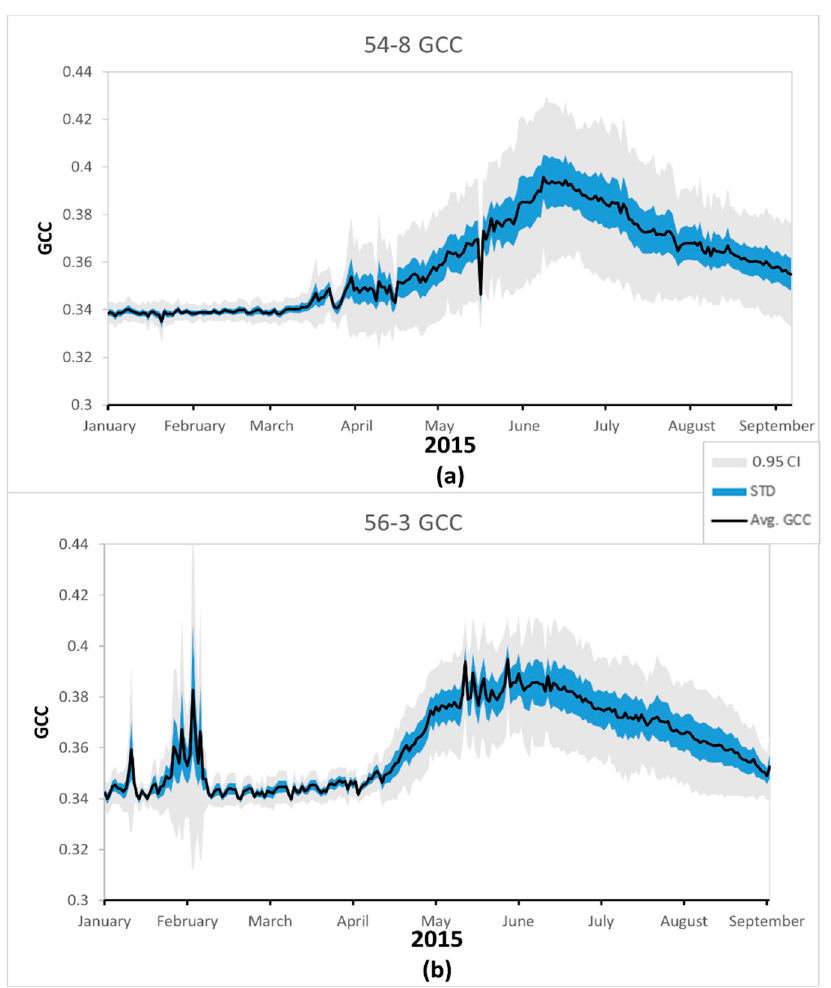
Figure 4. Daily GCC values from two rangeland sites 54-8 ( a ) with 4 cameras and 56-3 ( b ) with 5 cameras in the Idaho study area. Average GCC values for all cameras at a site is represented by the solid black line, one standard deviation (STD) is represented by the blue area and a 95% confidence interval (CI) is represented by the grey area.